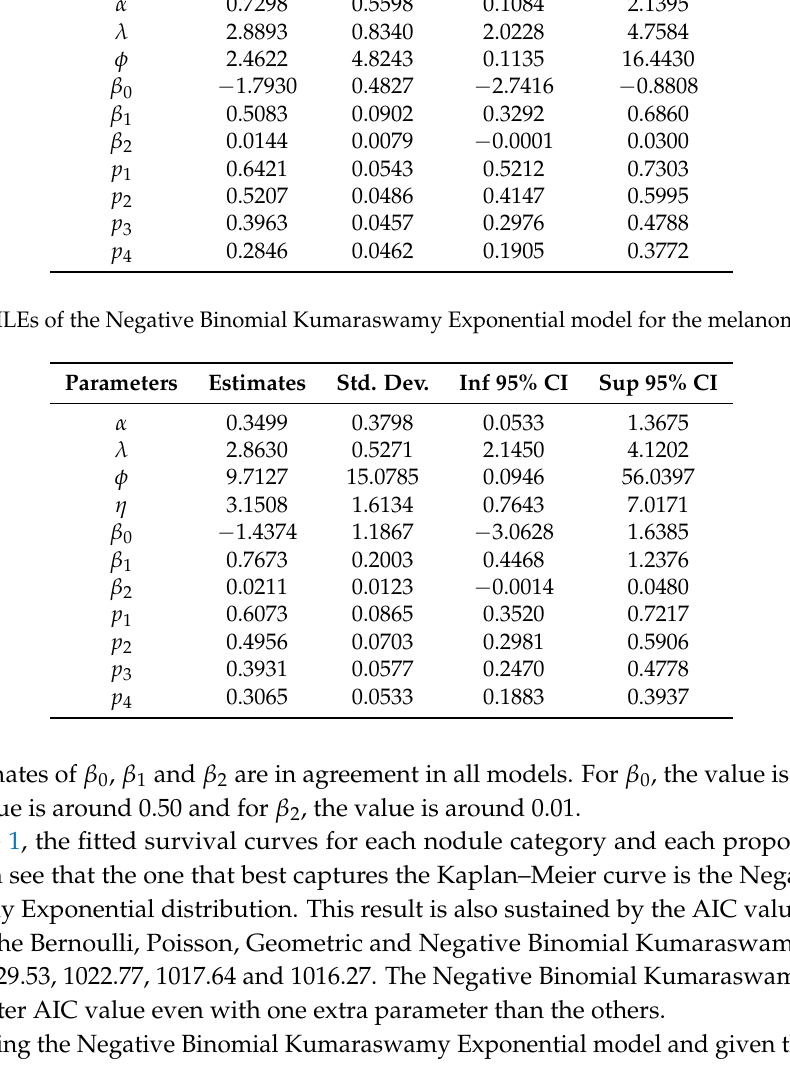
Table 5. MLEs of the Geometric Kumaraswamy Exponential model for the melanoma data set. Parameters